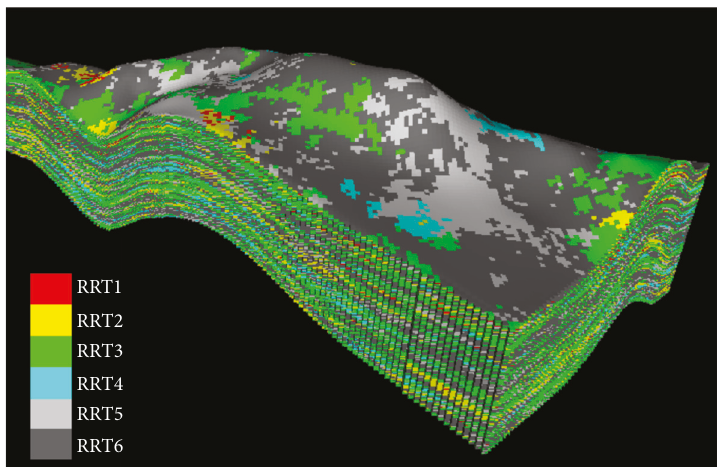
Figure 5: 3D rock type